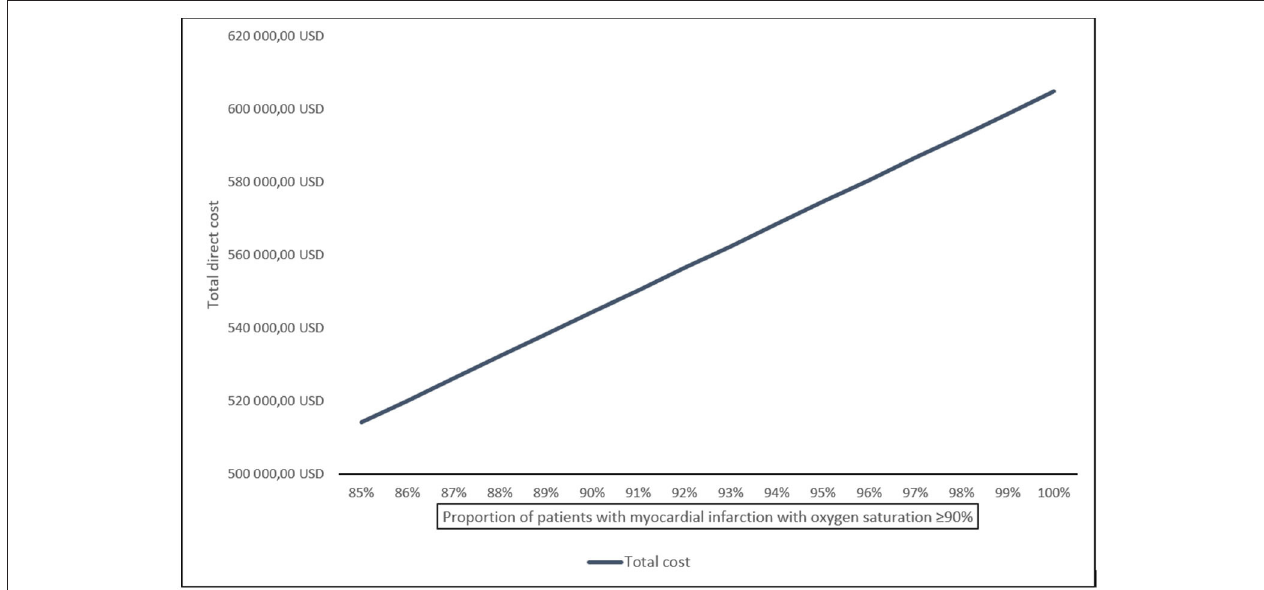
FIGURE 3 | Estimated total potential cost saving of oxygen therapy for patient with confirmed MI in Sweden annually, displayed by proportion of patients with oxygen saturation ≥ 90% at